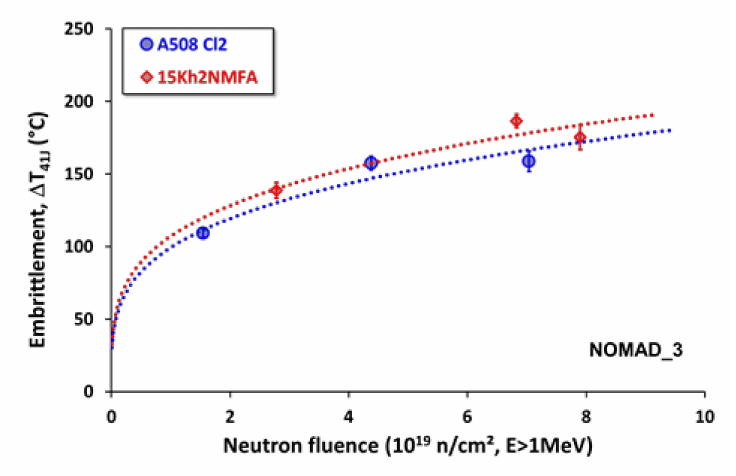
Figure 8. Embrittlement of 15Kh2NMFA and A508 Cl.2 after NOMAD_3 irradiation as a function of neutron fluence. The dashed lines are added to guide the eye (power law fit).